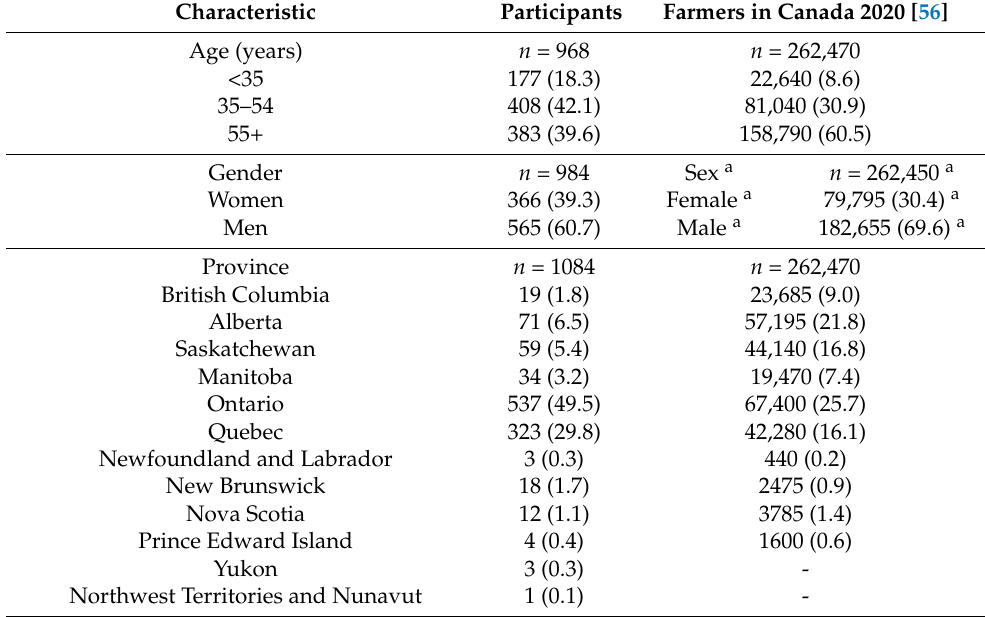
Table 2. Demographics of study participants (February–May 2021) ( n = 1167), and Canadian farmers from the 2021 Census of Agriculture ( n = 262,642)